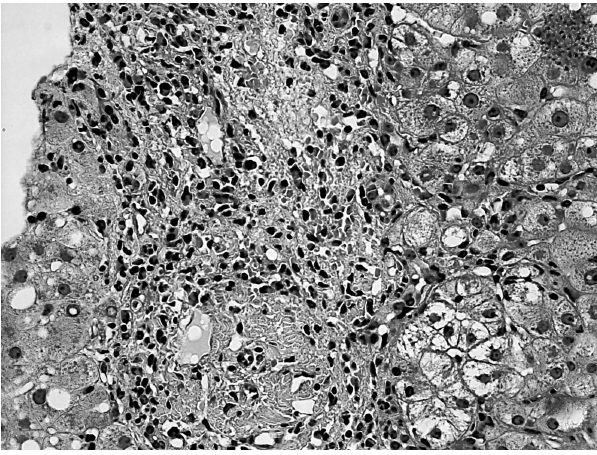
Figure 1 - Liver biopsy sections of active chronic hepatitis B infection without cirrhosis, but with intense inflammatory eosinophilic infiltration into the vessels and focal fibrinoid necrosis (hematoxylin and eosin, original magnification